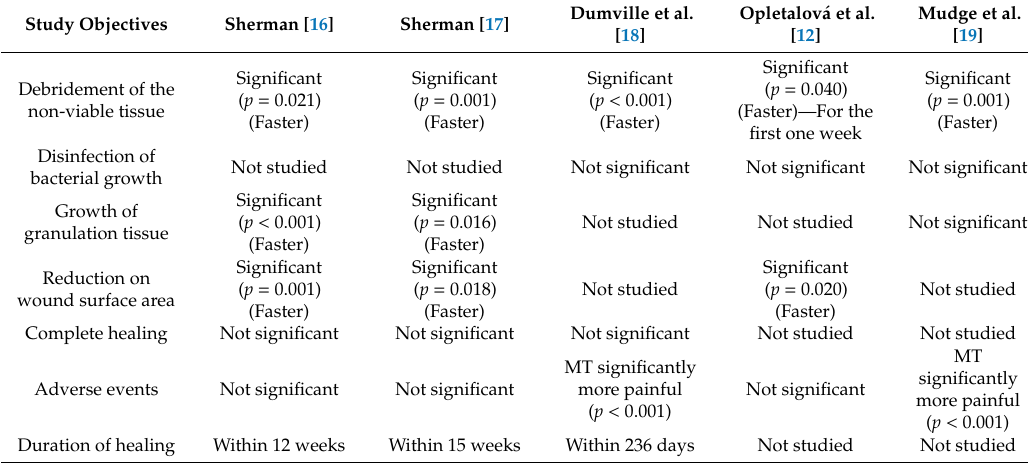
Table 3. Summary of